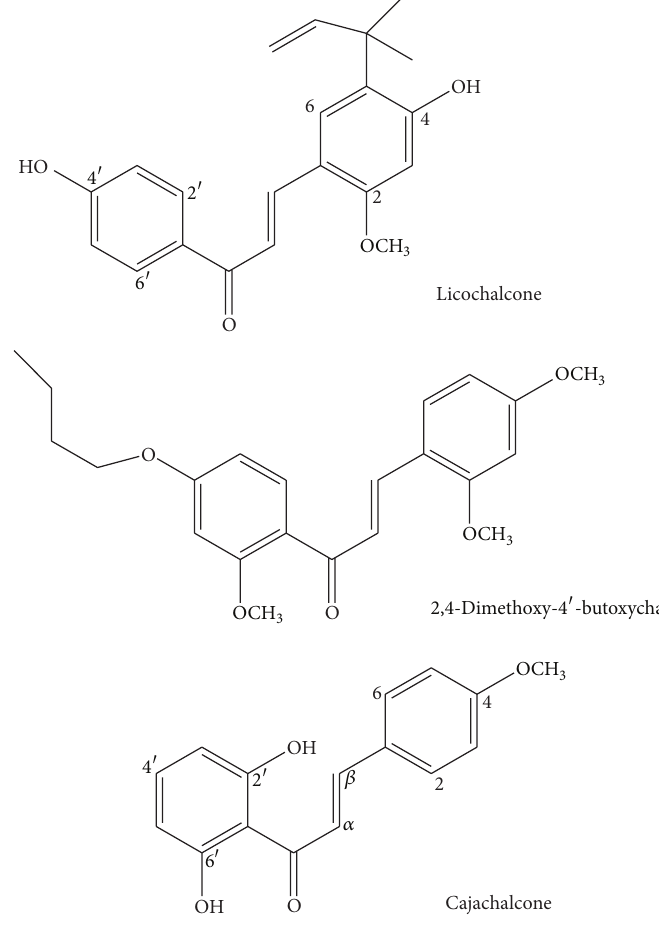
Figure 1: Structures of